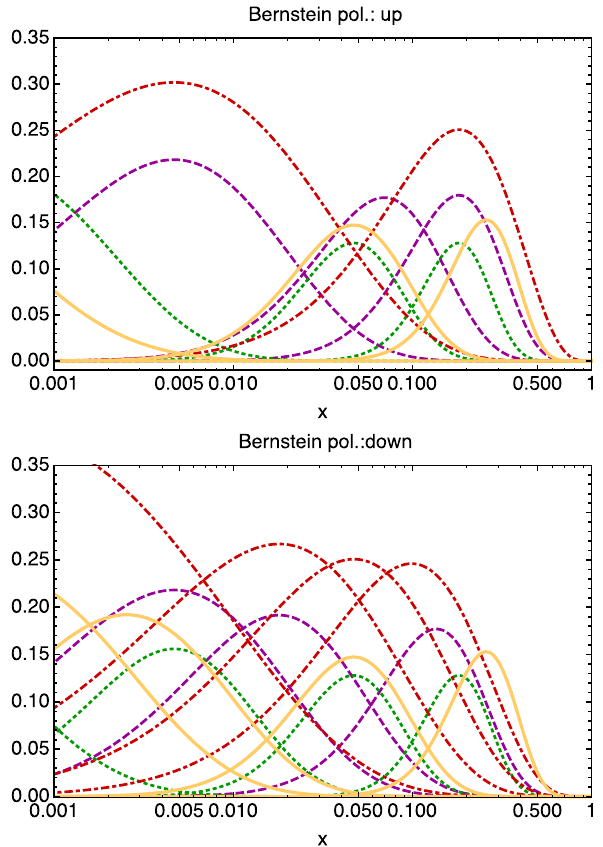
( g ( x )) used in the functional Fig. 3 Bernstein polynomials B k , n i form for the valence up transversity (upper) and the valence down transversity (lower). The degree of the polynomials is, respectively, n = { 10 , 20 , 30 , 40 } in red with dot-dashed contours, purple/dashed, yellow/full and green/dotted. See